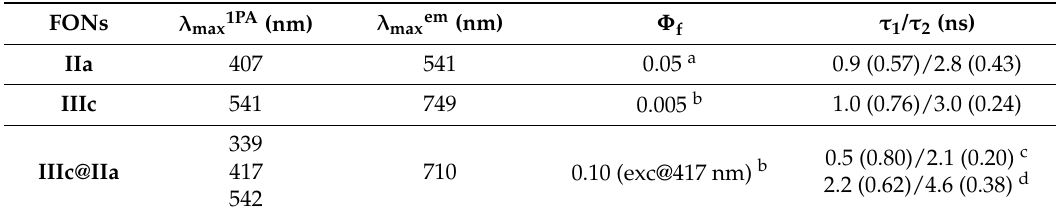
Table 6. Photophysical properties of core-shell FONs IIIc@IIa in water (compared to pure FONs IIIc and IIa